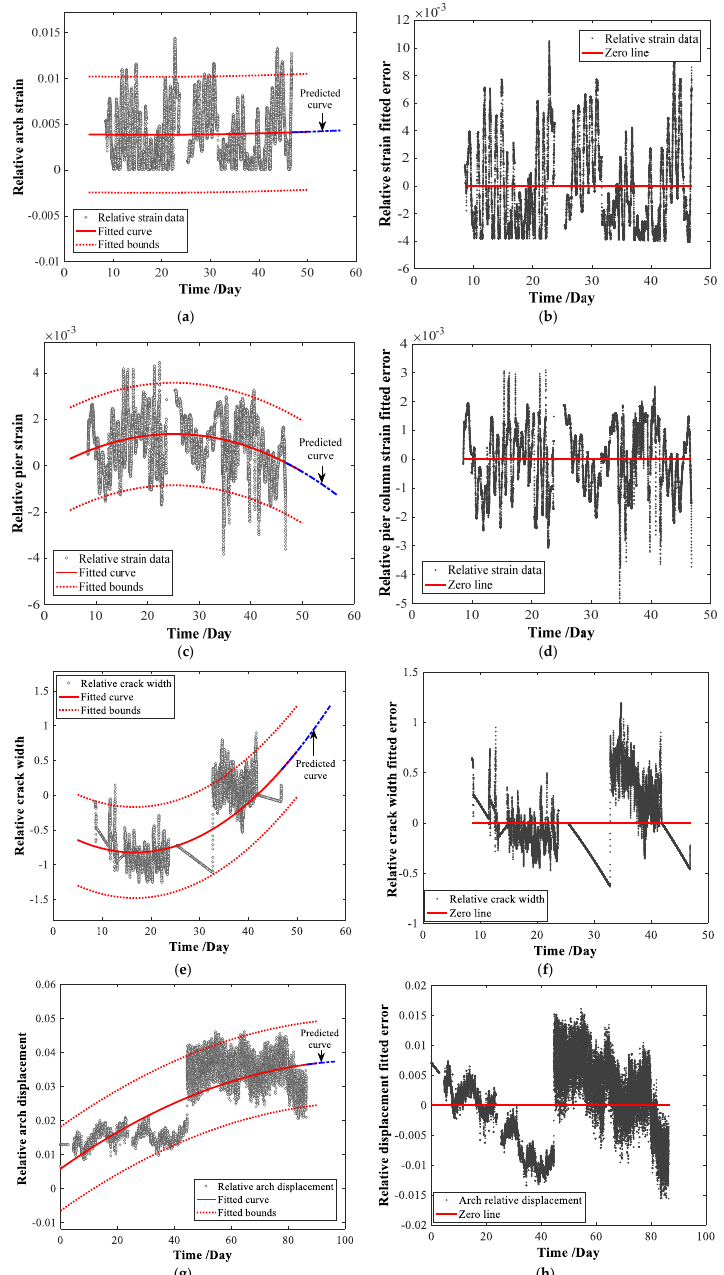
Figure 12. Parameter regression and prediction. ( a ) Relative arch strain. ( b ) Fitted error of arch